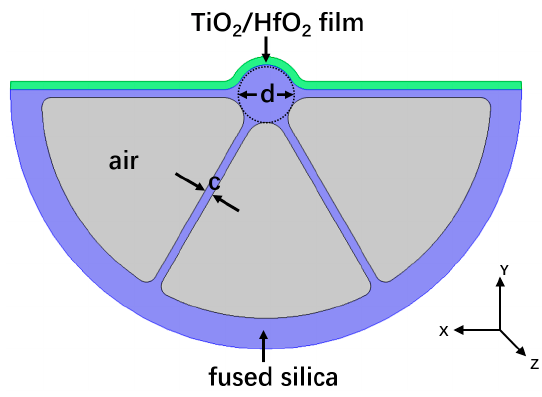
Figure 1. Schematic of a novel microstructure fiber sensor based on lossy mode resonance.